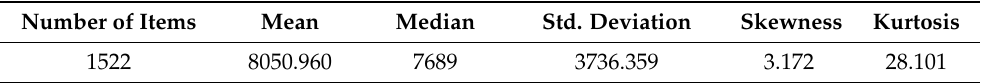
Table 2. Descriptive statistics for energy